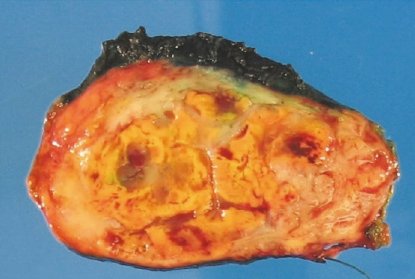
Figure 2: Macroscopic findings. Well circumscribed, pseudoencap- sulated, 12.5 cm mass with variegated cut